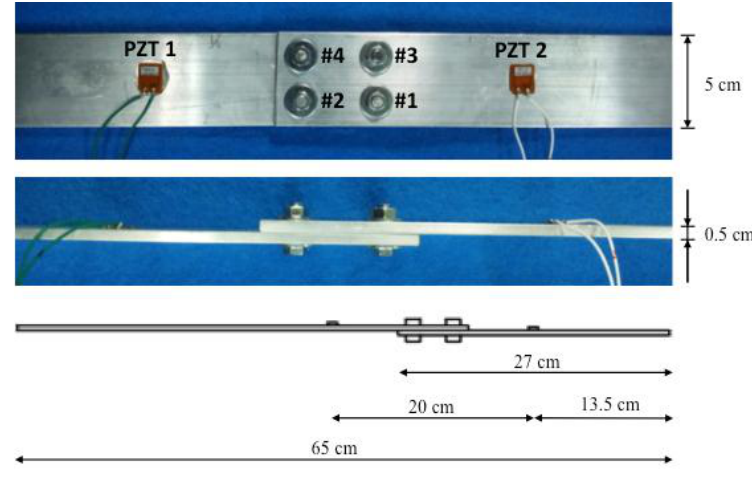
Figure 2. Bolt-jointed aluminium beam with two PZT transducers.